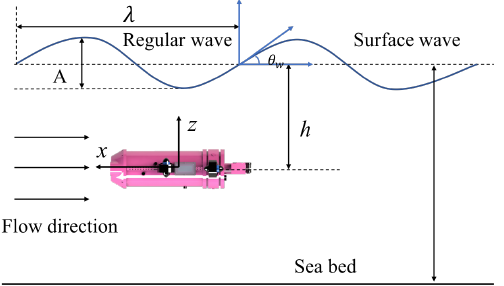
Figure 11. Schematic diagram of the Sharks-AUV subjected to surface